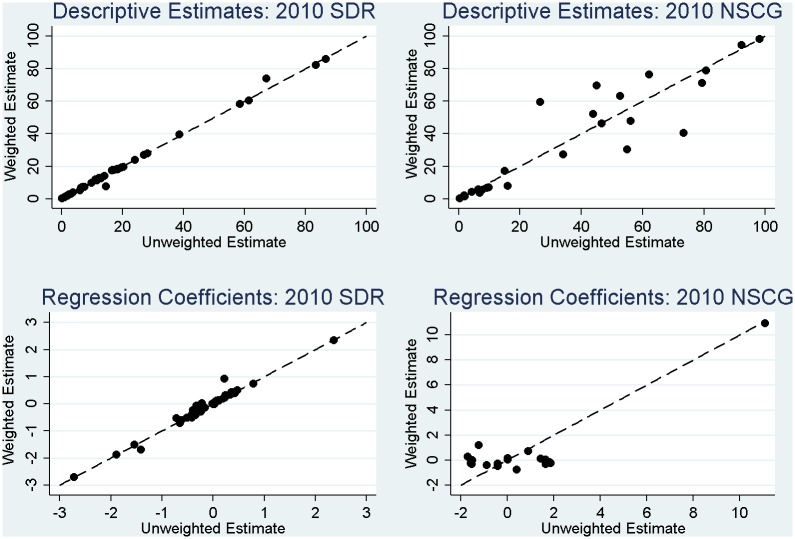
Correspondence between weighted and unweighted estimates of descriptive parameters and regression coefficients in the 2010 SDR and the 2010 NSCG (including a dashed 45-degree line representing perfect correspondence).